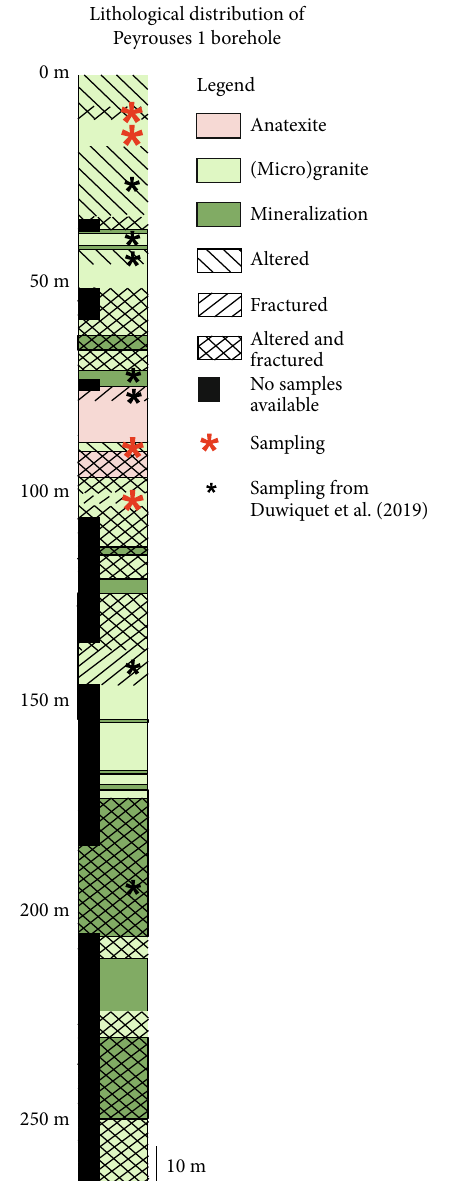
Figure 3: Distribution of lithologies and location of the various samples taken from the Peyrouses 1 borehole. Mineralization consists of mispickel, pyrite, tourmaline, pyromorphite, and galena. For the missing samples (in black on the fi gure), the description of the drilling done by BRGM in 1981 was